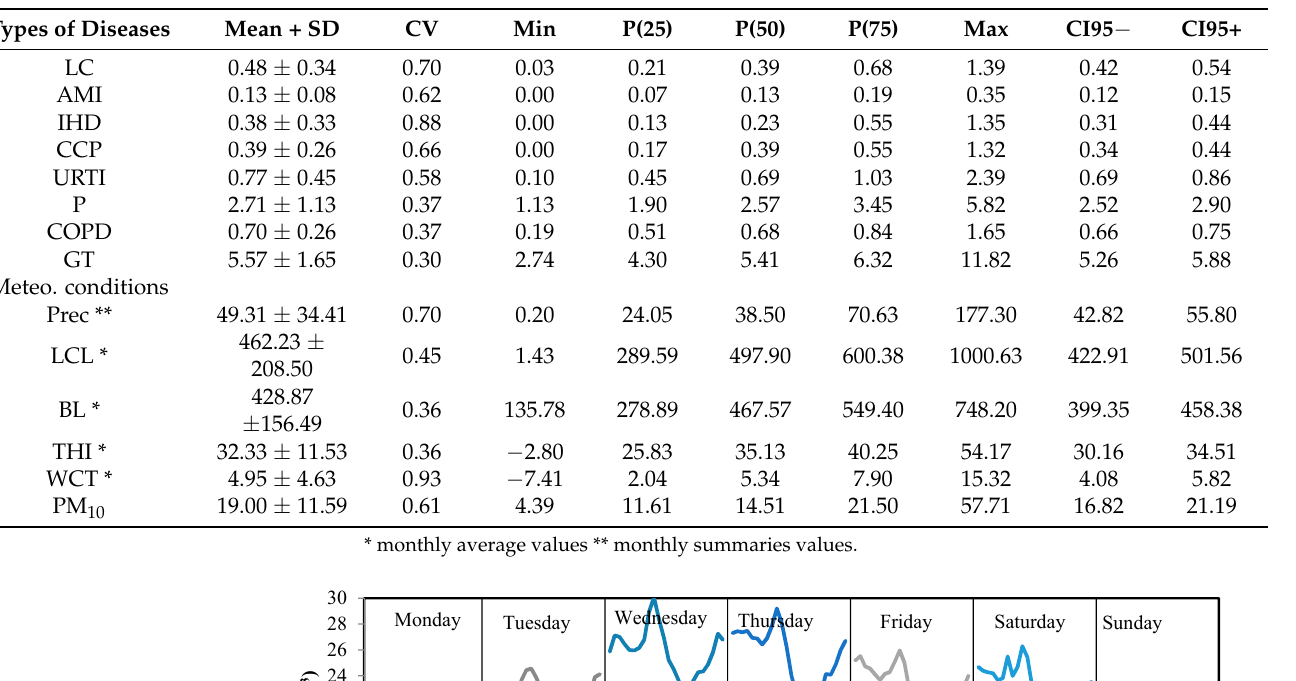
Table 1. Summary statistics of daily hospital admission numbers, meteorological conditions and PM 10 concentration. –LC: lung cancer; AMI: acute myocardial infarction; IHD: ischemic heart diseases; CCP: chronic cardiopulmonary disease; URTI: upper respiratory tract infections; P: pneumonia; COPD: chronic obstructive pulmonary diseases; GT: global trends; Prec.: precipitation; LCL: lifting condensation level; BL: boundary layer; THI: thermal humidity index; WCT: wind chill equivalent chart index.